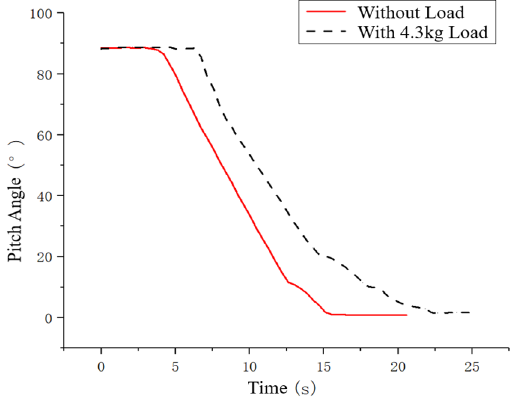
Figure 12. Time history of the robot’s pitch angle while crossing a 90° concave corner.